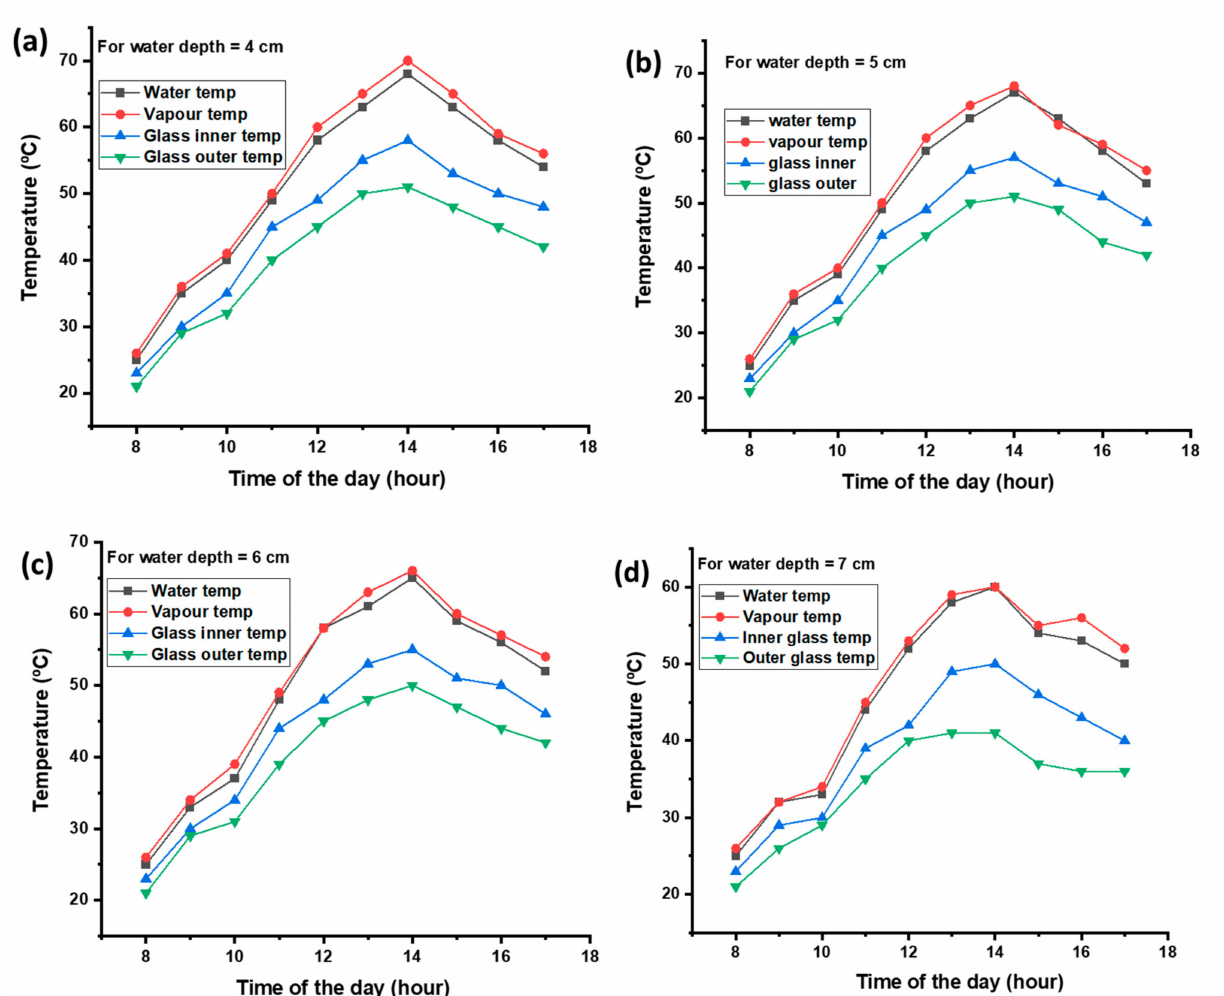
Figure 4. Hourly observation of temperature variations vs. time of the day with water depth = 4.0 cm